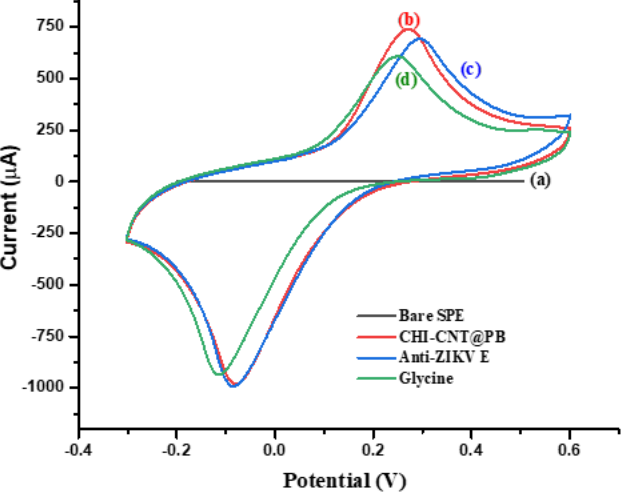
Figure 6. CVs of the stepwise preparation of the immunosensor: ( a ) bare SPE, ( b ) CHI–CNT@PB, ( c ) Anti-ZIKV E, ( d ) glycine (100 mmol · L − 1 ). Measurements were performed in the presence of KCl ( c ) Anti-ZIKV E, ( d ) glycine (100 mmol.L − 1 ). Measurements were performed in the presence of KCl (100 mmol · L − 1 ) for a 0.05 V · s − 1 scan (100 mmol.L − 1 ) for a 0.05 V s −1 scan rate.